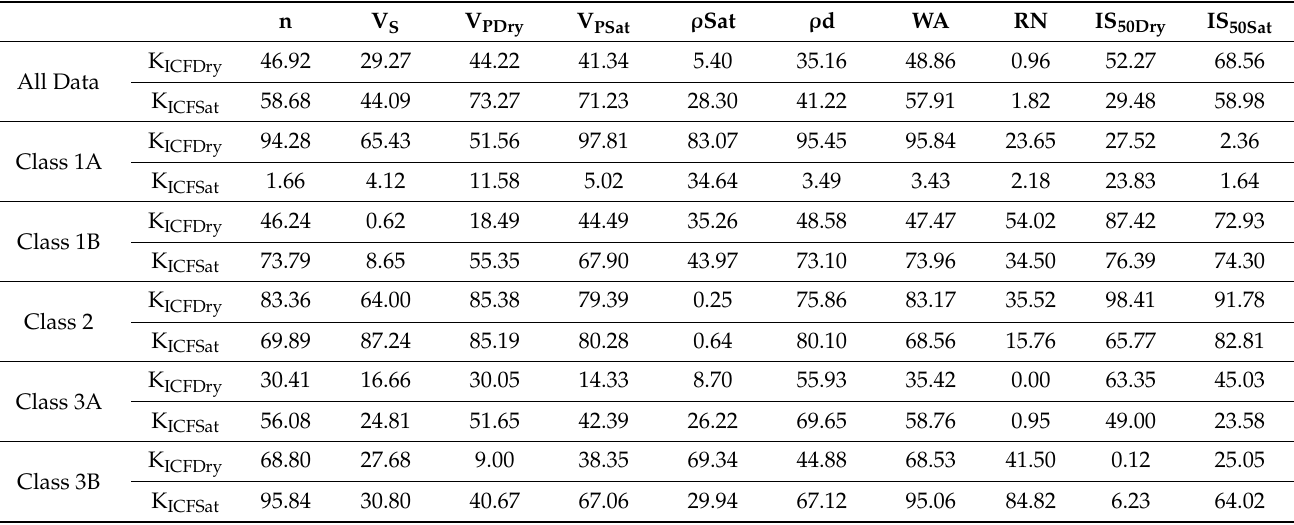
Table 7. Linear correlation between the index properties and dry and saturated fracture toughness for all of the limestones and individual classes.